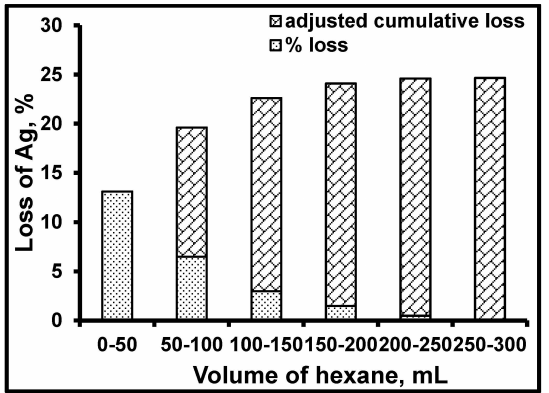
Figure 10. Percent loss of Ag from Ag/Co 3 O 4 under flow conditions using hexane as the